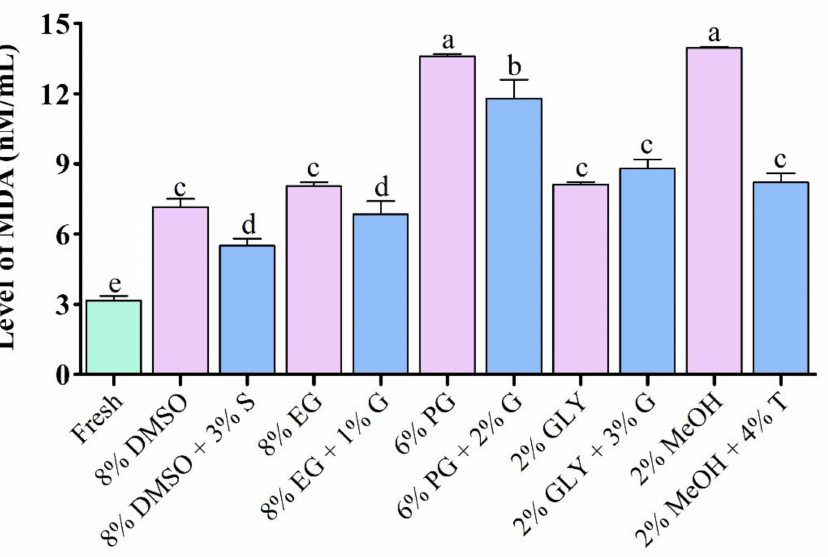
Figure 8. Lipid peroxidation (MDA) activities in different types of post-thaw sperm cryopreserved using saccharides. DMSO: dimethyl sulfoxide, EG: ethylene glycol, PG: propylene glycol, GLY: glycerol, MeOH: methanol, S: sucrose, G: glucose, T: trehalose. Results are presented as mean values ± standard deviation ( n = 10). Significantly different levels ( p < 0.05) are denoted by differ- ent